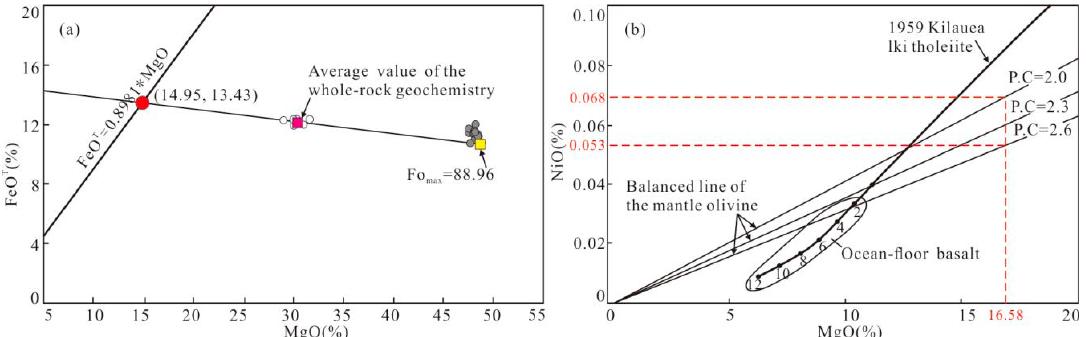
Figure 13. MgO-FeO T diagrams of extrapolation method for primary magma estimation ( a ) modified after Tao et al. (2002) [40]); MgO-NiO diagram of magma composition in equilibrium with mantle peridotite during fractional crystallization of primary magma ( b ) modified after Sato (1977) [41]), in the Niubiziliang Ni-(Cu) deposit.